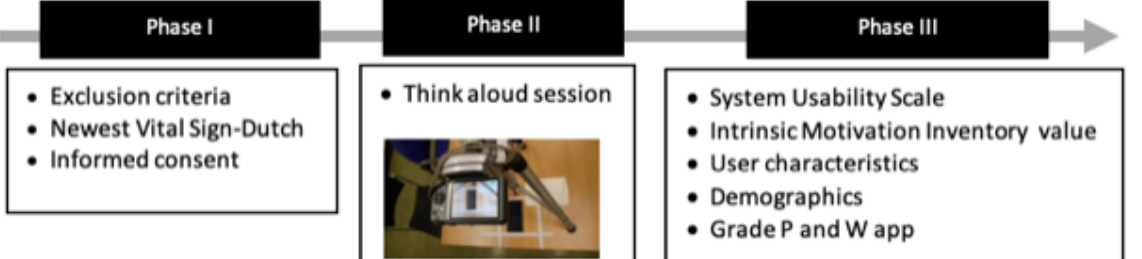
Figure 2. Overview of study